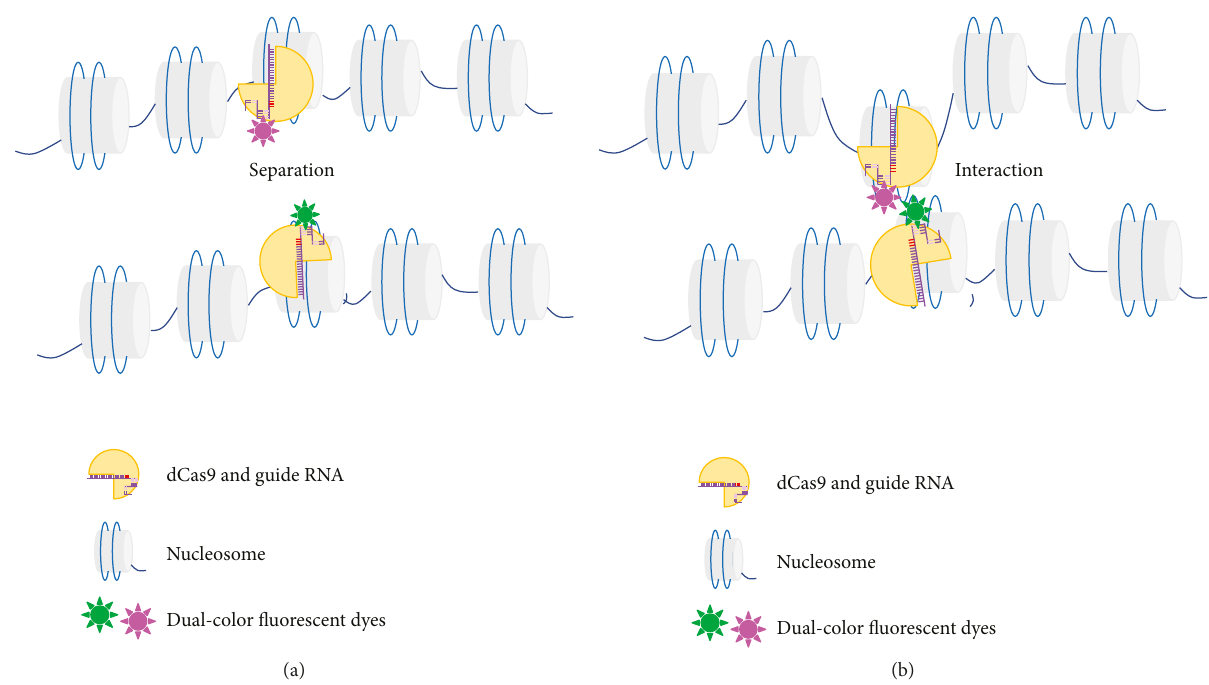
Figure 4: In vivo imaging of chromatin interaction mediated by Cas9. Guide RNAs direct dCas9 and fl uorescent proteins to bind with selected DNA targets, forming the dCas9-gRNA- fl uorescent dye complex. At chromosomal level, spatial position changes between chromosomal regions could be re fl ected by the (a) seperation or (b) interaction of the dual-color fl uorescent